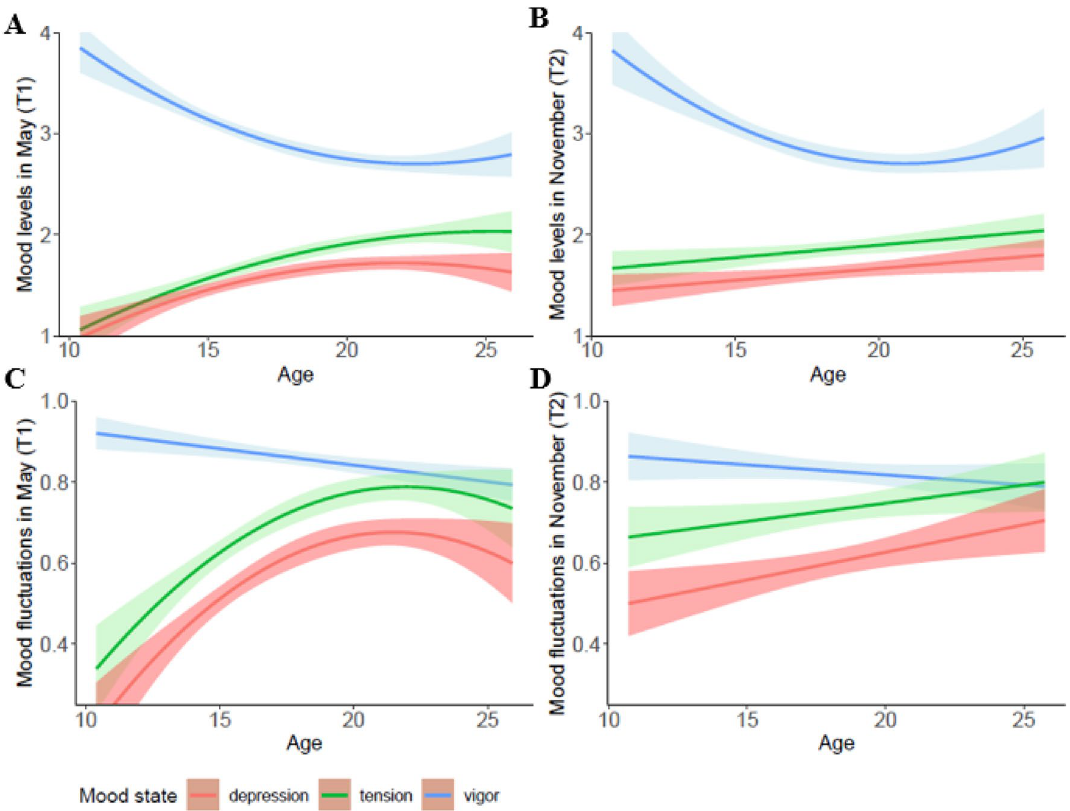
Figure 1. Graph A: adolescents and young adults reported higher levels of vigor compared to tension and depression in May 2020 (T1). All three mood levels showed quadratic age effects, with a drop in vigor and a peak in tension and depression in young adulthood. Graph B: adolescents and young adults reported higher levels of vigor compared to tension and depression in November 2020 (T2). Vigor showed a quadratic age effect with a drop in young adulthood, whereas tension and depression mean levels showed positive linear effects. Graph C: Adolescents and young adults reported more fluctuations in vigor, compared to tension and depression, which was specifically pronounced among younger adolescents at T1. Fluctuations in vigor showed a negative linear effect as a function of age, while tension and depression fluctuations peaked during late adolescence/young adulthood. Graph D: Adolescents show more vigour fluctuations compared to tension and depression fluctuations at T2. This disparity is less profound among young adults. There was no age effect of vigour fluctuations. However, tension and depression fluctuations showed a positive linear age effect across